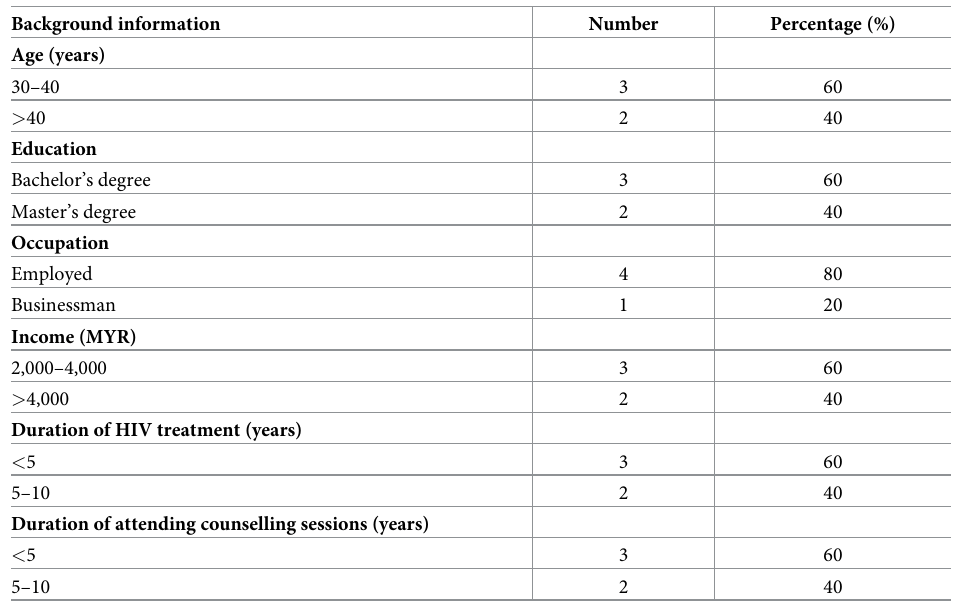
Table 1. Participants’